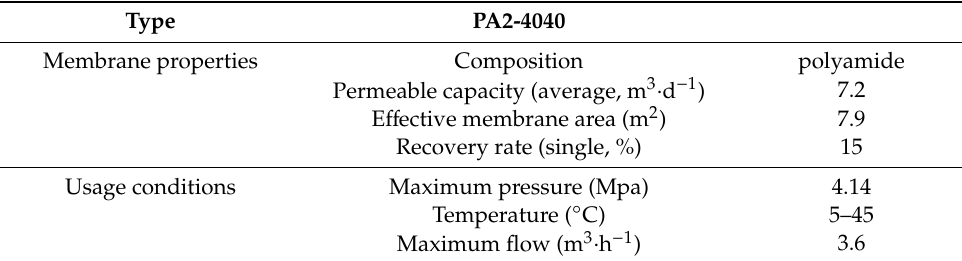
Table 1. Main characteristics of the used membrane.